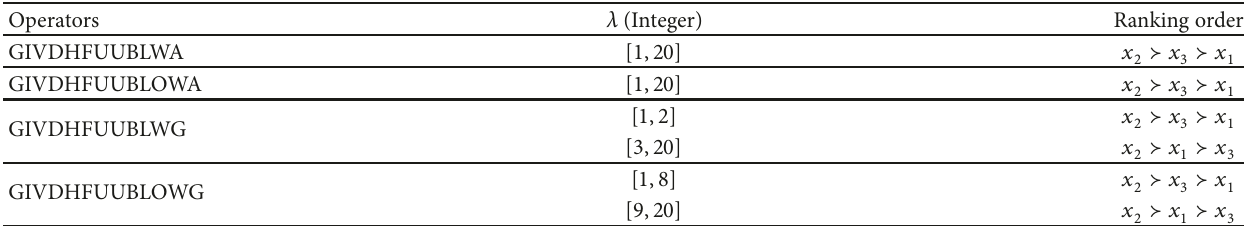
Table 6: Ranking orders obtained by GIVDHFUUBLWA, GIVDHFUUBLOWA, GIVDHFUUBLWG, and GIVDHFUUBLOWG along with 𝜆 . Operators